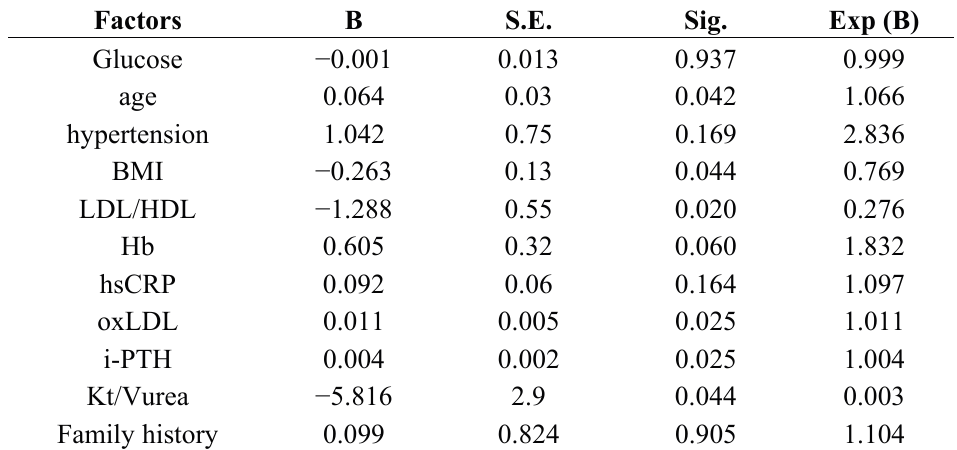
Figure 2. Correlation between glucose serum concentrations and insulin resistance defined by HOMA-IR ( n = 76, r = 0.753, p = 0.001). Table 2. Correlation between glucose serum concentrations and coronary disease in patients on hemodiafiltration after adjustment for risk